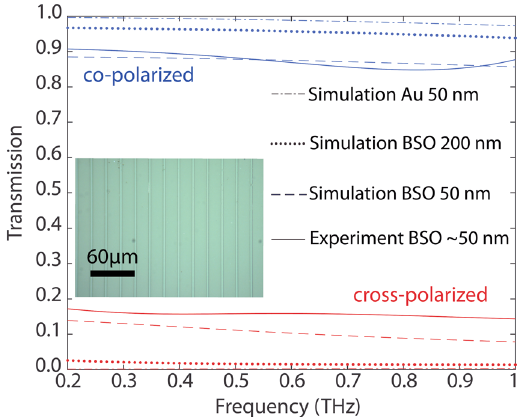
Figure 6. Co-polarized and cross-polarized transmission through polarizer structures. The continuous traces indicate our experimental results. Dotted and dashed curves represent modeled data. The inset shows an optical image of the fabricated sample, which is transparent to visible